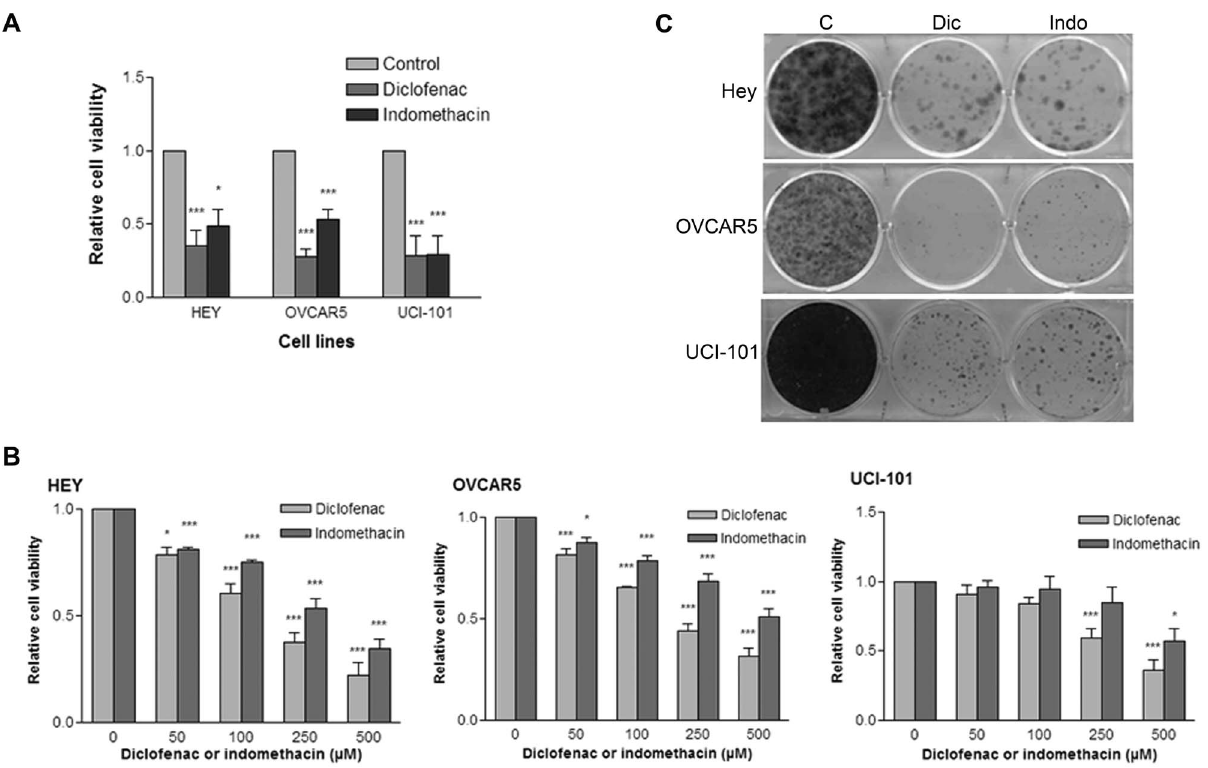
Figure 1. NSAIDs decrease the viability of ovarian cancer cells in a dose-dependent manner. A) HEY, OVCAR5 or UCI-101 cells were treated for 48 hours with 300 m M diclofenac or indomethacin. Cells were then incubated with MTS reagents and absorbance at 490 nm was measured after 1 hr incubation at 37 u C. The average of 3 experiments is shown. Statistical significance is represented as follows: * p , 0.05 and *** p , 0.001. B) Cells were treated for 24 hours with the indicated concentrations of diclofenac or indomethacin. Cell viability was measured using an MTS assay. The average of 3 experiments is shown. Statistical significance is represented as follows: * p , 0.05 and *** p , 0.001. C) Cells were treated for 48 hours with 300 m M diclofenac or indomethacin, washed and allowed to grow for a total of 7 to 14 days. Cells were then stained with crystal violet. Image shown is representative of 3 experiments.